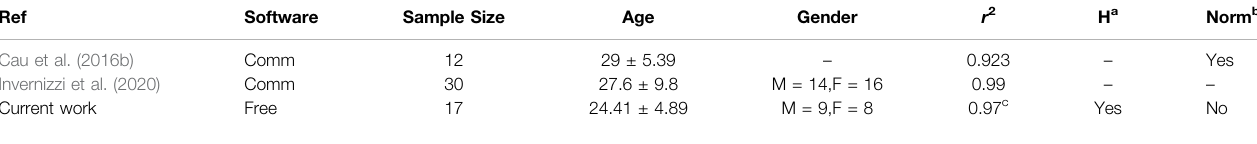
TABLE 7 | Healthy subject upper limb volume: digital volumes vs circumferential measurement. Ref